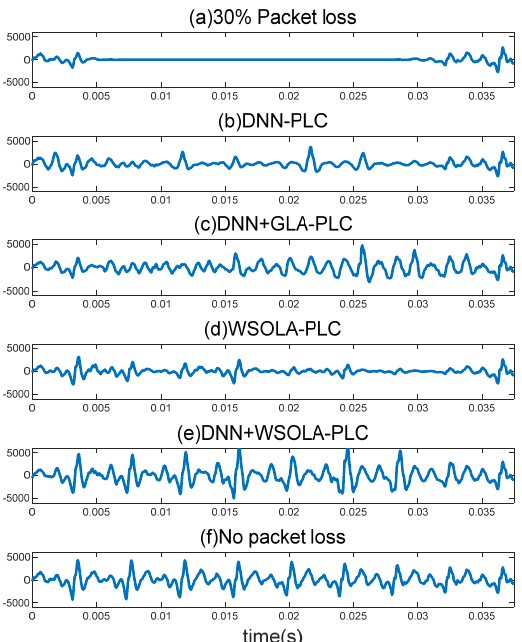
Figure 11. Waveform comparison: ( a ) 30% packet loss; ( b ) DNN − PLC; ( c ) DNN+GLA − PLC; ( d ) WSOLA − PLC; ( e ) DNN+WSOLA − PLC; ( f ) no packet loss.